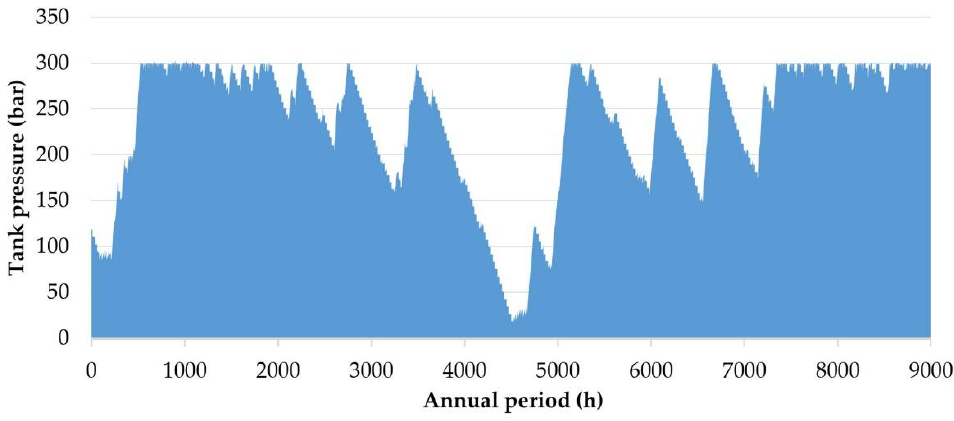
Figure 16. Map of the potential circular ship voyage for the daily maritime connection between Sifnos and the neighboring islands.